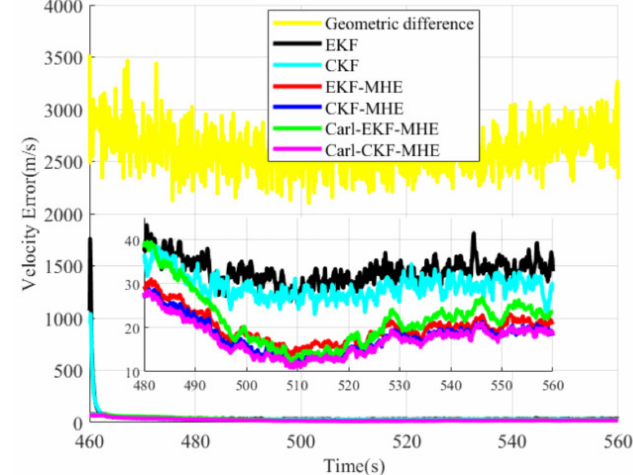
Figure 9. Velocity estimation errors.